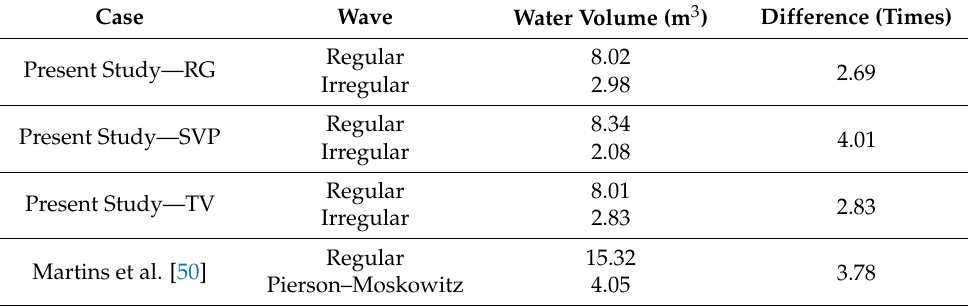
Table 5. Water accumulated in 100 s of